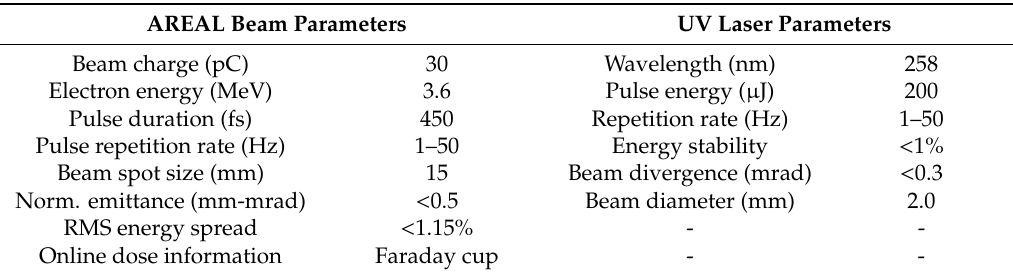
Table 1. Characterization of the AREAL laser-generated electron